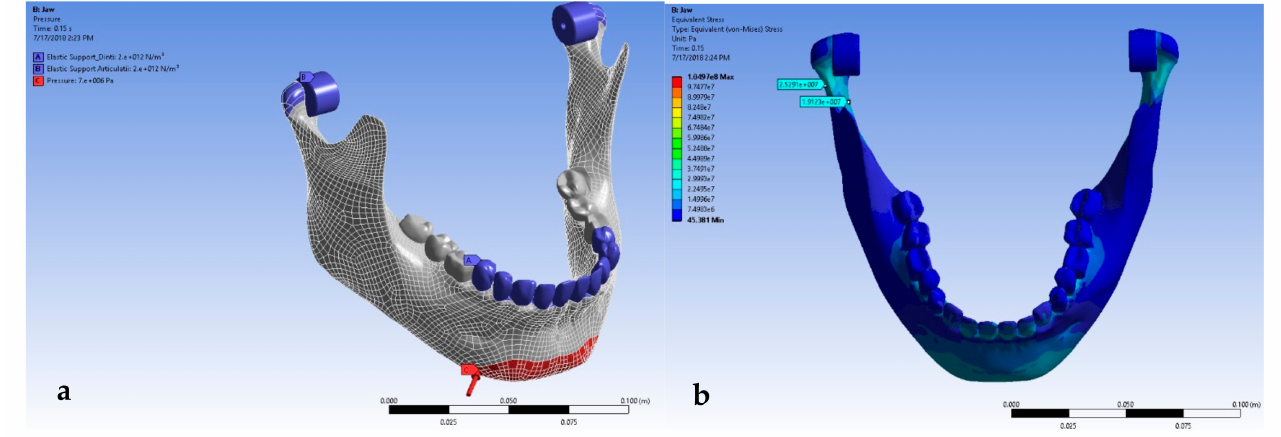
Figure 12. ( a ). If both hemiarches’ first, second, and third molars are absent, the force acts on the anterior face of the chin region (A-elastic support teeth 2 × 10 12 N/m 3 ; B-elastic support joint 2 × 10 12 N/m 3 ; C-pressure 7 × 10 7 Pa). ( b ) The equivalent stress on the surface of the mandible